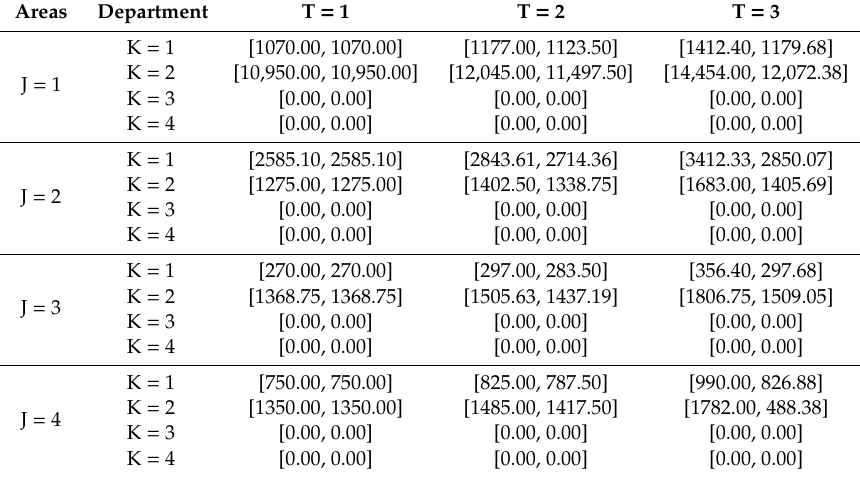
Table 1. The range of treatment capacity of sewage discharged by various water use departments in area j during the period t (10 4 tons /